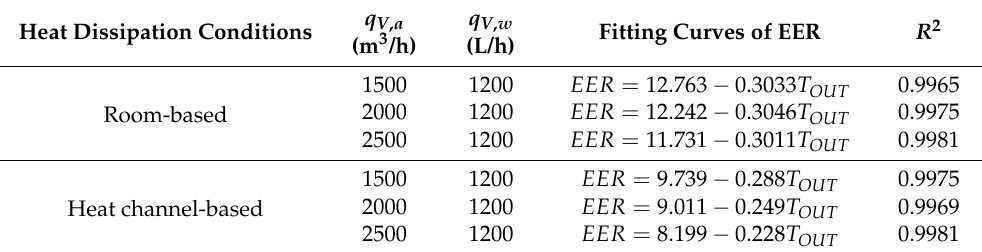
Table 8. Fitting curves of EER of the SNCS module under two conditions. Heat Dissipation Conditions